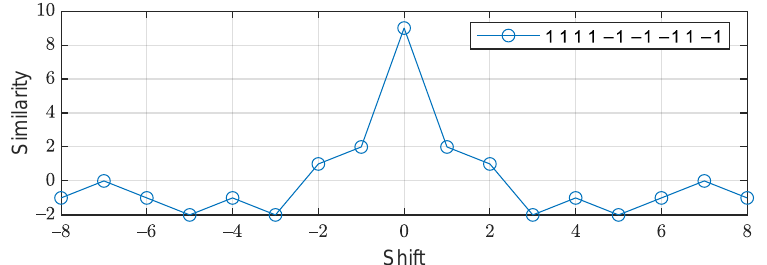
Figure 17. Auto-correlation of used spreading sequence.